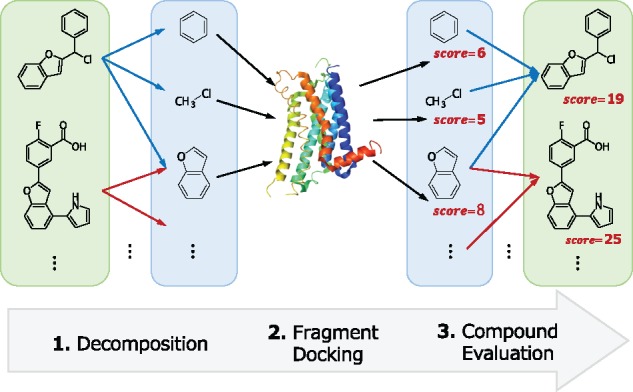
Spresso flowchart